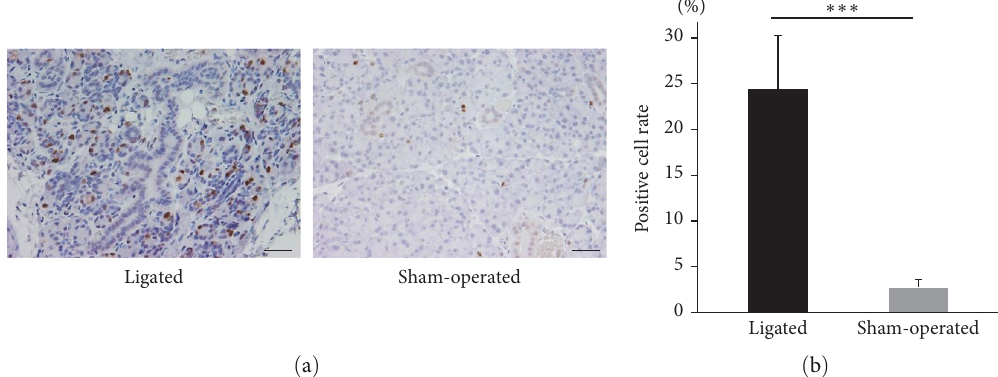
F IGURE 3: Cell proliferative capacity of parotid glands 7 days postduct ligation. (a) Immunohistochemical staining of Ki67 (brown) in ligated parotid and sham-operated glands. Scale bar = 30 µ m. (b) Ki67-positive cell rate of ligated and sham-operated glands. The cell proliferation rate increased signi fi cantly in duct-ligated parotid glands. The number of cells was counted in three fi elds (magni fi cation 400 × ) of each sample. ∗∗∗ Indicates signi fi cance at P < 0 : 005. Data were shown as mean Æ SD ( n =